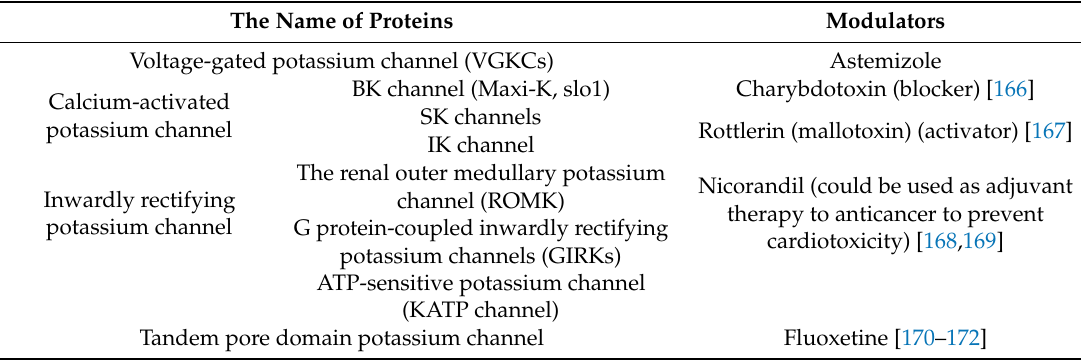
Table 3. Proteins that regulate potassium ion dynamics involved in carcinogenesis with potential